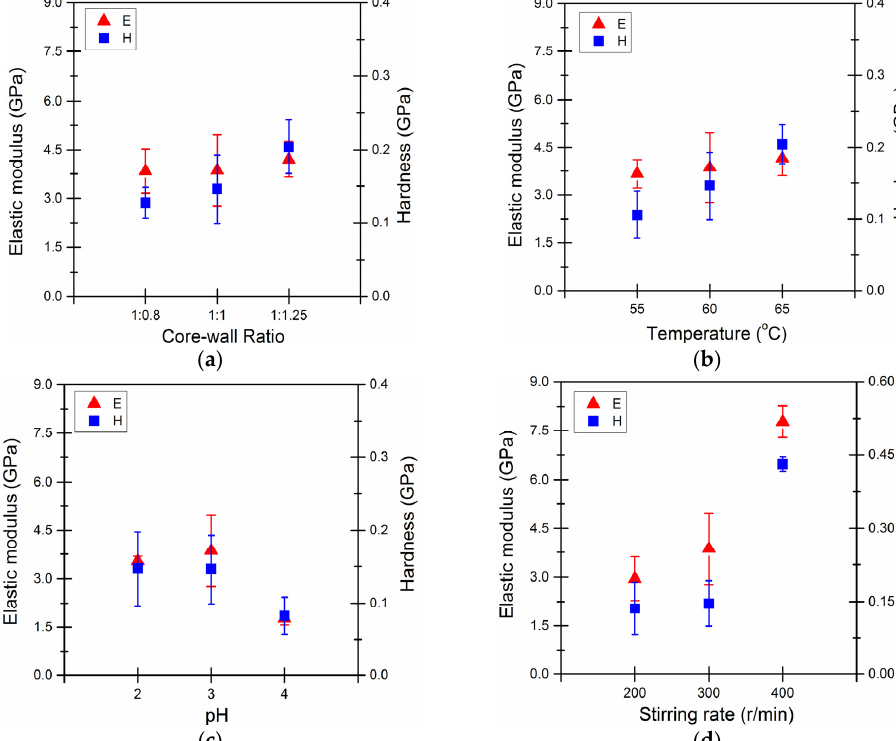
Figure 11. Effect of ( a ) core-wall ratio; ( b ) reaction temperature; ( c ) pH value and ( d ) stirring rate on elastic modulus (‘E’) and hardness of microcapsules (‘H’).